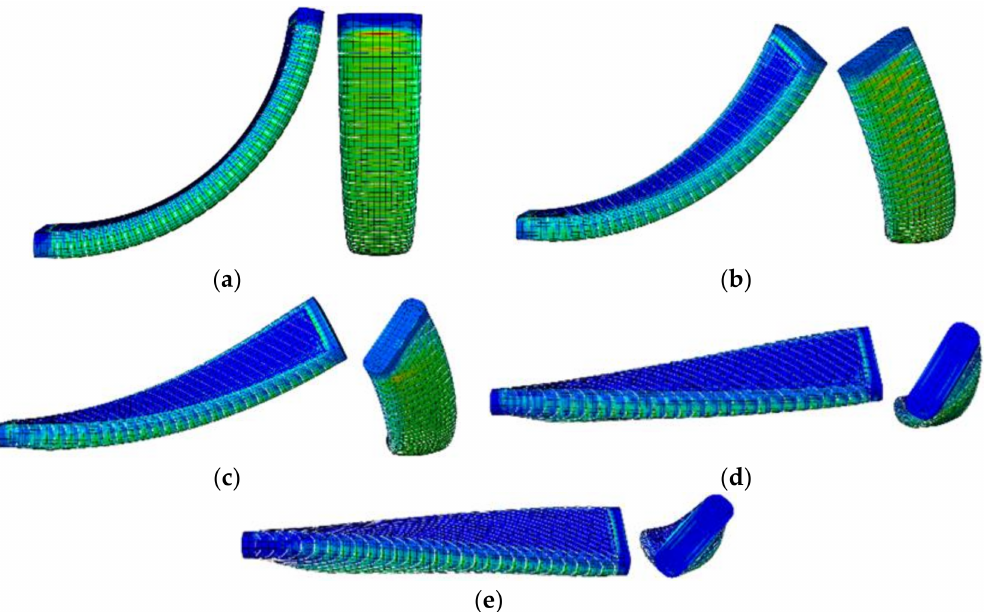
Figure 4. Bending and twisting of the actuator at different fiber inclinations. ( a ) Fiber inclination γ = 0 ◦ ; ( b ) fiber inclination γ = 15 ◦ ; ( c ) fiber inclination γ = 30 ◦ ; ( d ) fiber inclination γ = 45 ◦ ; ( e ) fiber inclination γ = 60 ◦ .